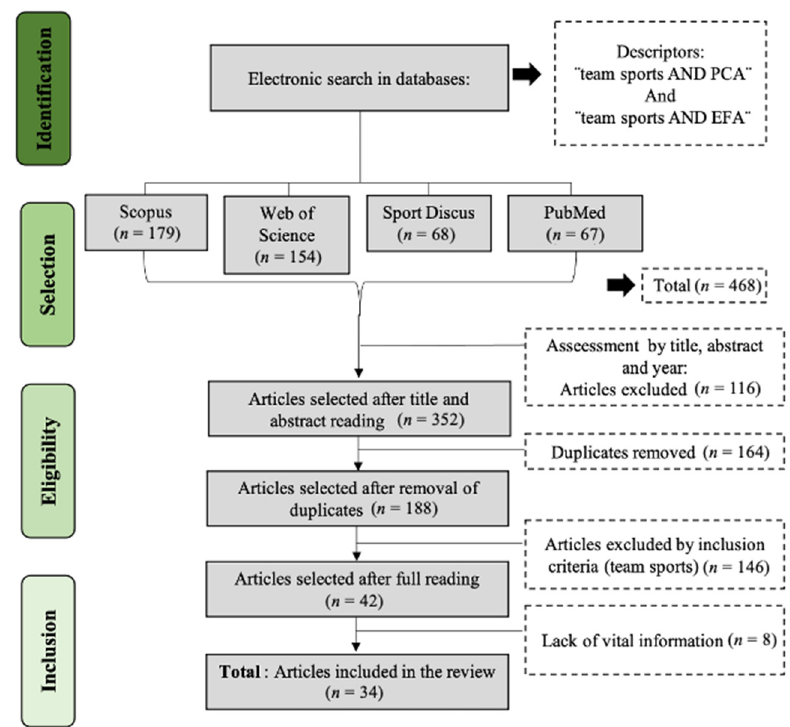
Figure 1. Flow diagram of the study.